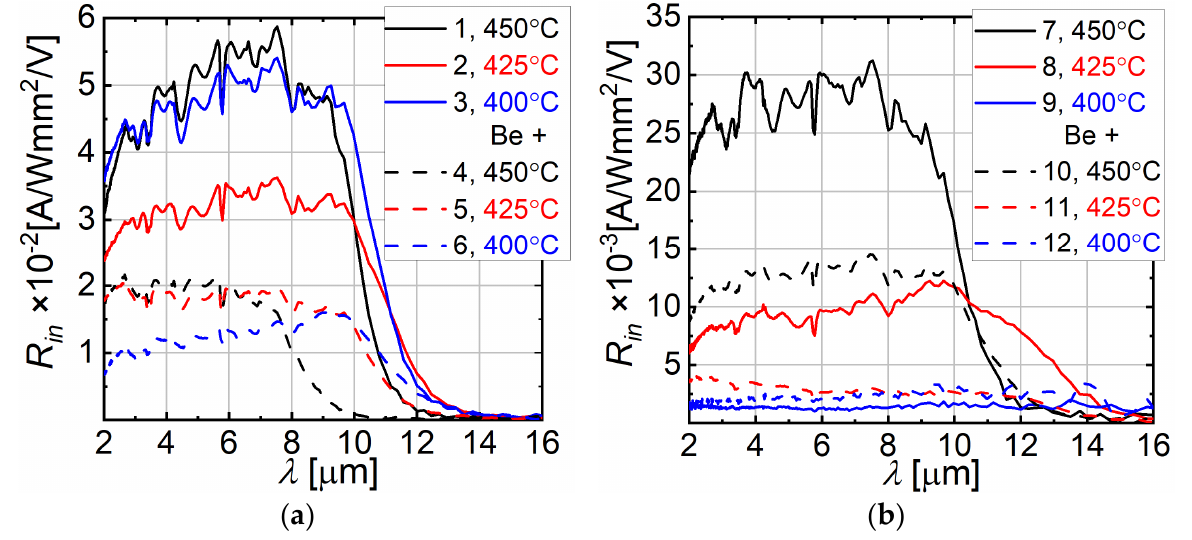
Figure 5. Spectral response characteristic at 210 K for T2SLs from ( a ) Set I and ( b ) Set II.